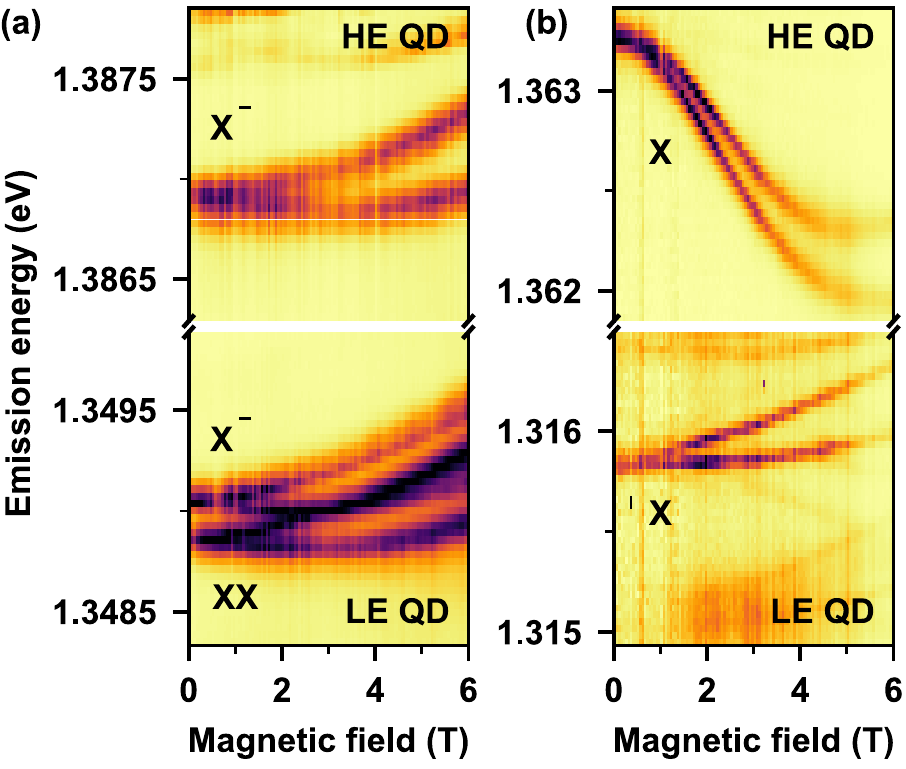
Figure 2. Magnetic field dependence of the emission spectra of ( a ) DQD1 with inter-dot spacing of L 1 = 9.5 nm and ( b ) DQD2 with L 2 = 7 nm. Magnetic decoupling of the high-energy (HE) and low-energy (LE) dots is observable in ( b ) as a downward shift in the energy of the HE